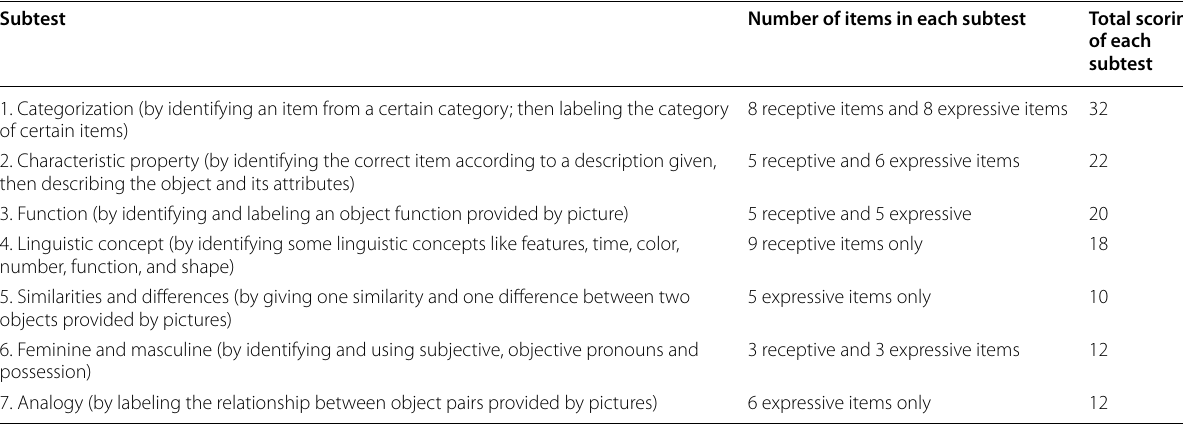
Table 1 Items of the semantic section of the Bilingual English-Arabic Test by Maged et al.